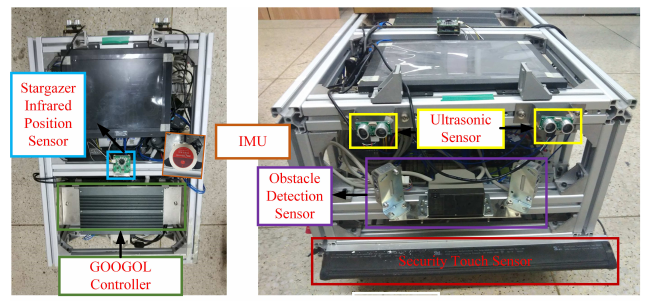
Figure 5. Experiment platform of